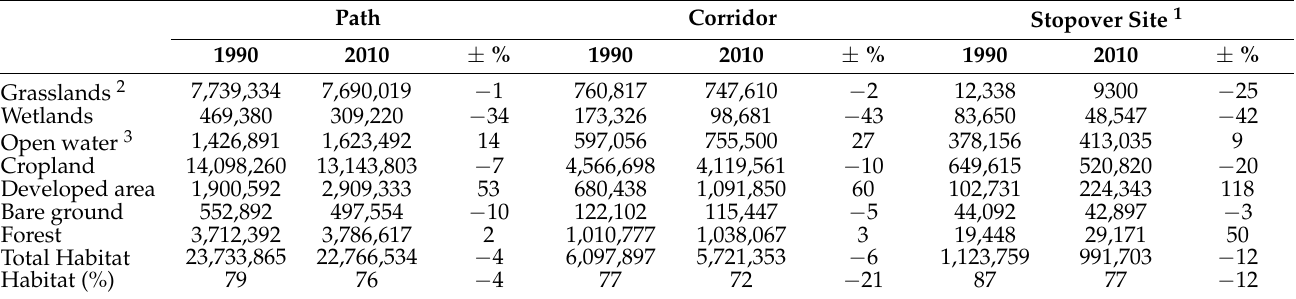
Table 4. Landcover (ha) within the early Beidaihe migratory path. Path Corridor